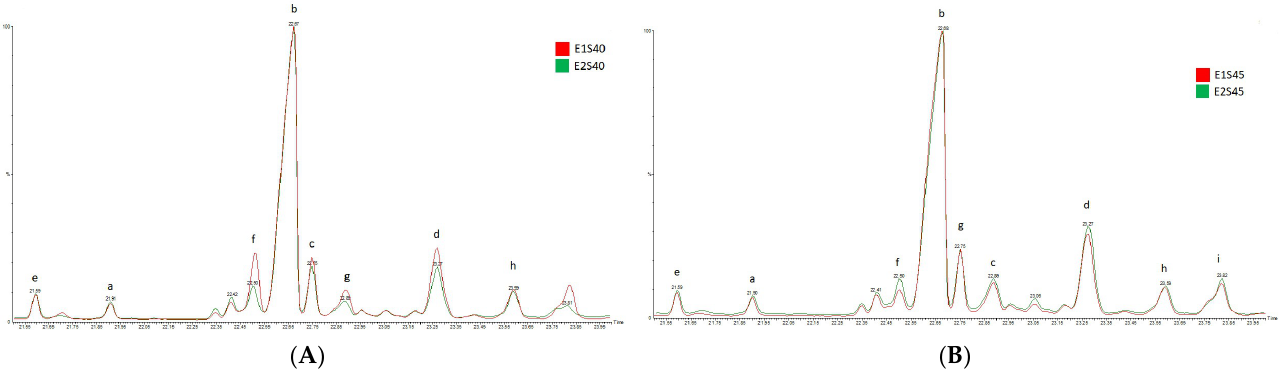
Figure 2. Phytosterol composition of SFE-CO 2 SBP oil fractions (a—campesterol; b— β -sitosterol; c— β -amyrin; d— α -amyrin; e–i—not identified). ( A ) fractions derivated from SFE-CO 2 extraction at 35 °C/45MPa (E1) and 37.5 °C/36.5MPa (E2), respectively, in separator S45, ( B ) fractions derivated from SFE-CO 2 extraction at 35 °C/45MPa (E1) and 37.5 °C/36.5MPa (E2), respectively, in separator S40